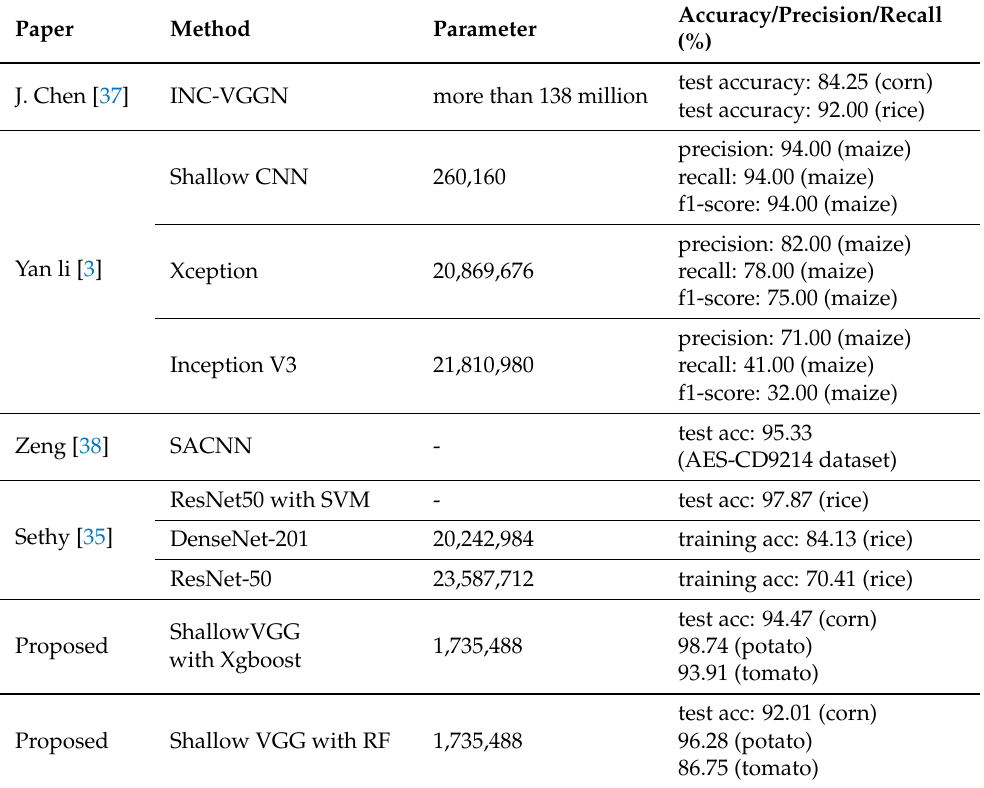
Table 12. Performance comparison with other deep learning